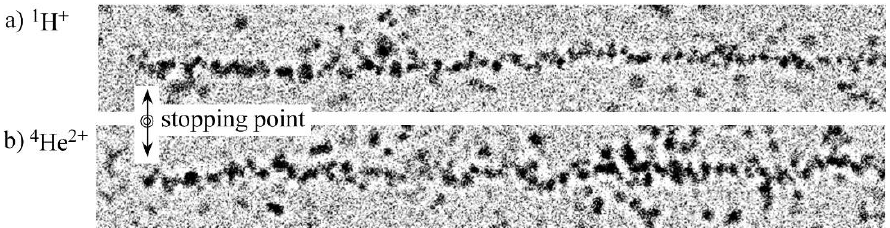
Fig. 3. Images taken by X-ray microscopy for tracks of a) 1 H + and b) 4 He 2+ around their stopping